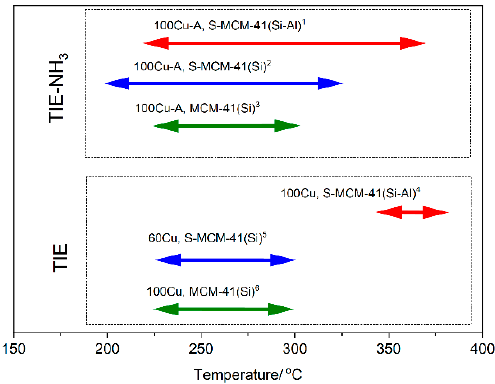
Figure 12. Comparison of the temperature ranges of the NO conversion over 90% for the most active catalysts obtained by TIE-NH 3 and TIE methods: 1 silica-alumina spherical MCM-41 modified with copper by TIE-NH 3 method, selectivity to N 2 (S N2 ) in this range above 95%, this studies; 2 pure silica spherical MCM-41 modified with copper by TIE-NH 3 method, S N2 > 98% [11]; 3 pure silica spherical MCM-41 modified with copper by TIE-NH 3 method, S N2 > 97% [12]; 4 silica-alumina spherical MCM-41 modified with copper by TIE method, S N2 > 95%, this work; 5 pure silica spherical MCM-41 modified with copper by TIE method, S N2 > 98% [11]; 6 pure silica spherical MCM-41 modified with copper by TIE method, S N2 > 97% [12].